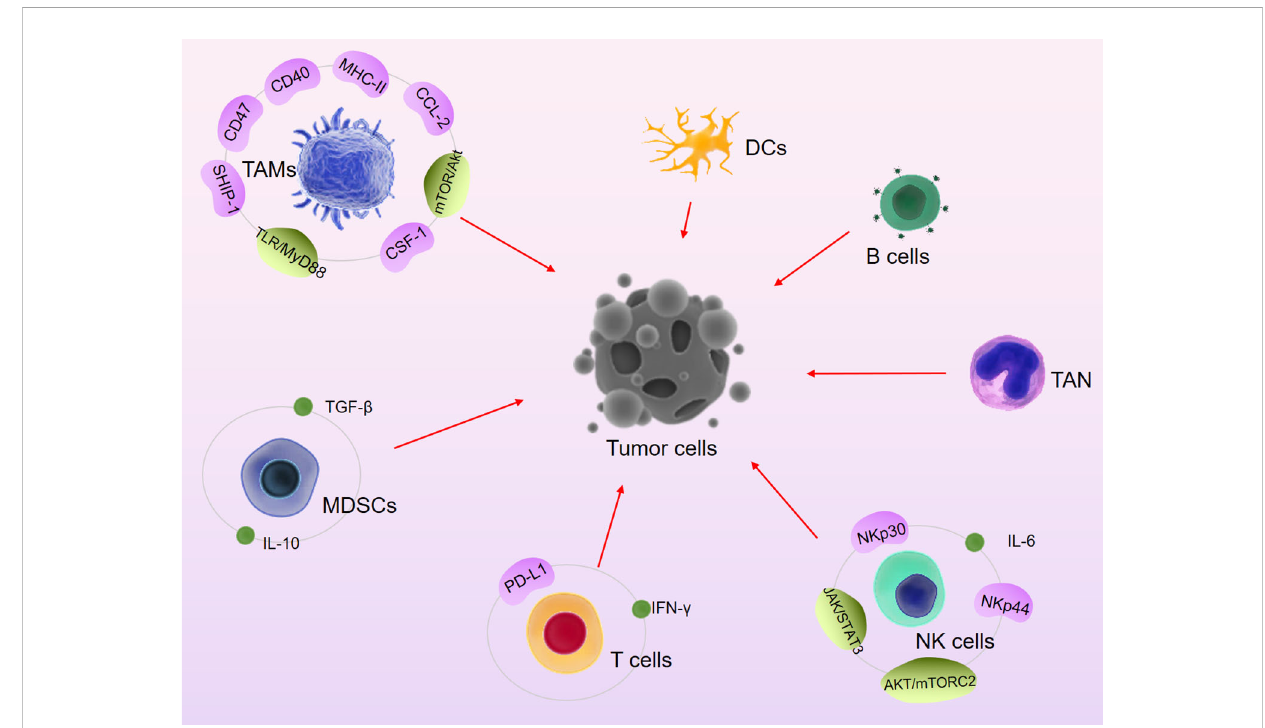
FIGURE 1 Major signaling pathways and immune cells involved in TCM-mediated anti-tumor immune